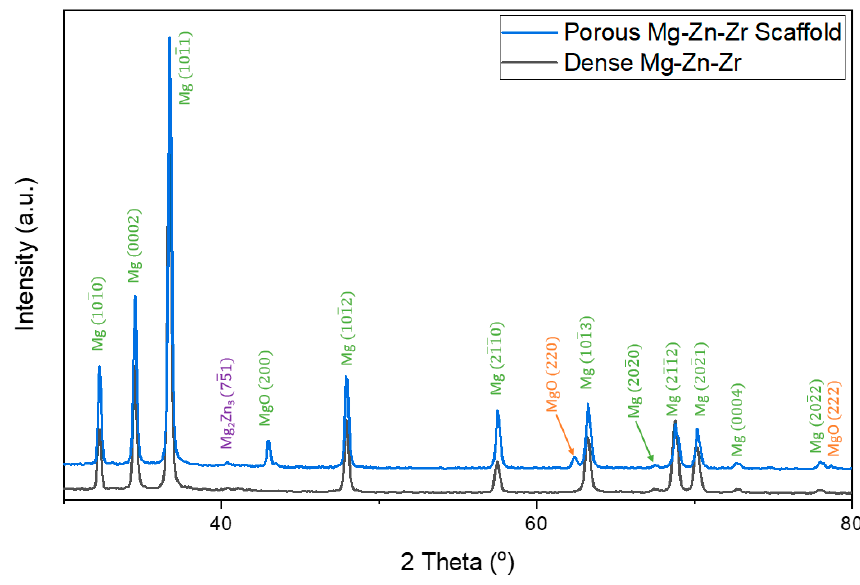
Figure 3 . XRD characterisation of dense Mg-Zn-Zr and porous Mg-Zn-Zr scaffold. Figure 3. XRD characterisation of dense Mg-Zn-Zr and porous Mg-Zn-Zr